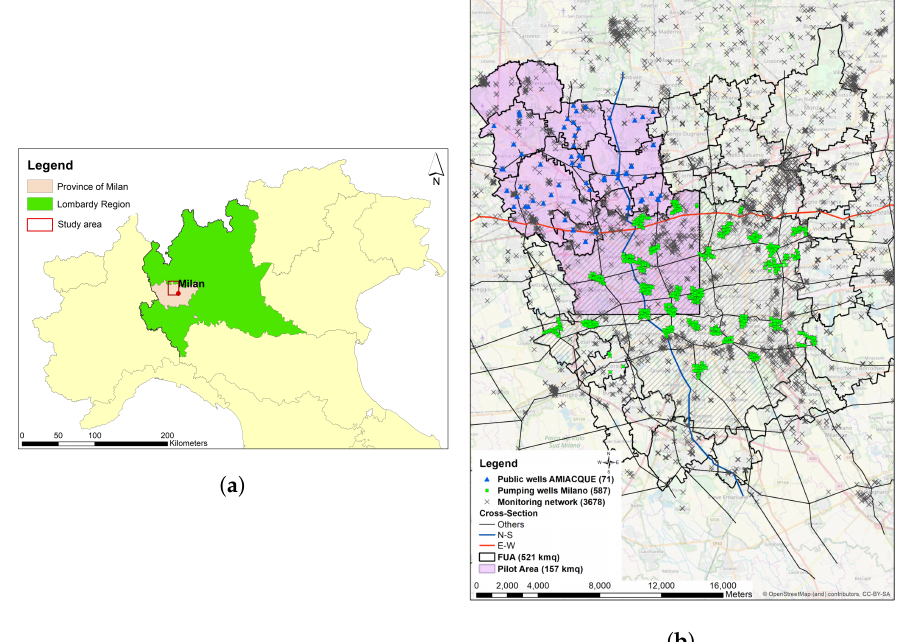
Figure 1. ( a ) Functional Urban Area (FUA) within the Lombardy Region and Milano Province, ( b ) FUA and pilot area (Municipalities involved in the AMIIGA project are colored by violet whereas the Milano City is line filled. Hydrogeological cross sections are represented by